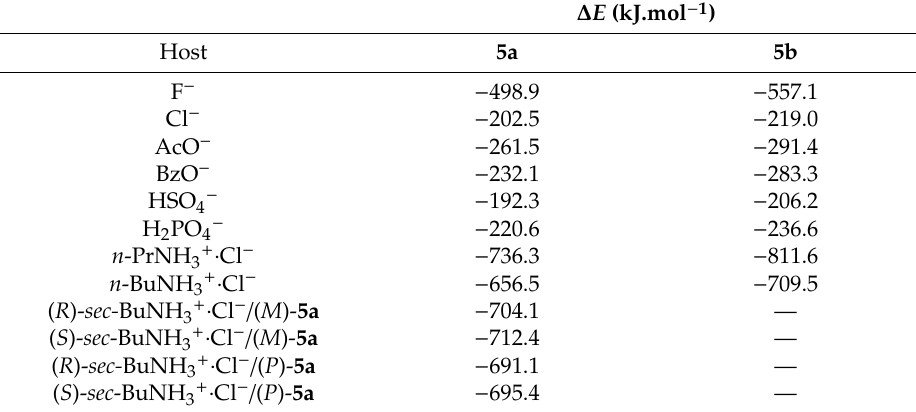
Table5. B3LYP / 6-31G(d.p) + BG3BJcomplexationenergies ∆ E (inkJ.mol − 1